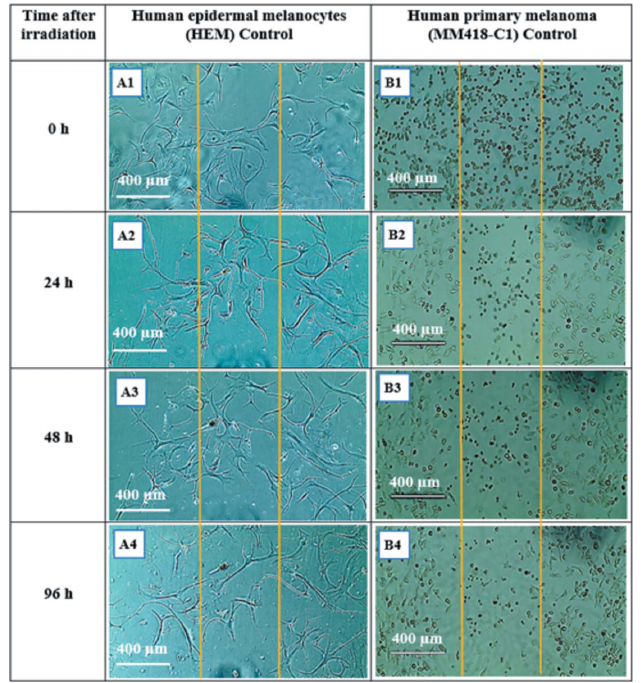
Figure 12 Human epidermal melanocytes HEM and human primary melanoma MM418-C1 monolayer 24 h after being exposed to 1000 Gy 90 kVp SBB (width 500 m m). Both cell types are control with no AuNPs treatment. The boundaries of the radiation fields are marked with orange lines. (A1) HEM immediately after exposure, (A2) 24 h, (A3) 48 h and (A4) 96 h after exposure. (B1) MM418-C1 immediately after exposure, (B1) 24 h, (B2) 48 h and (B4) 96 h after exposure.